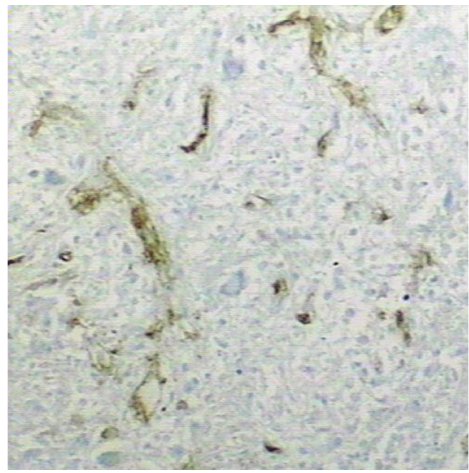
Figure 5: CD34 was positive for case 1 (MaxVision ×